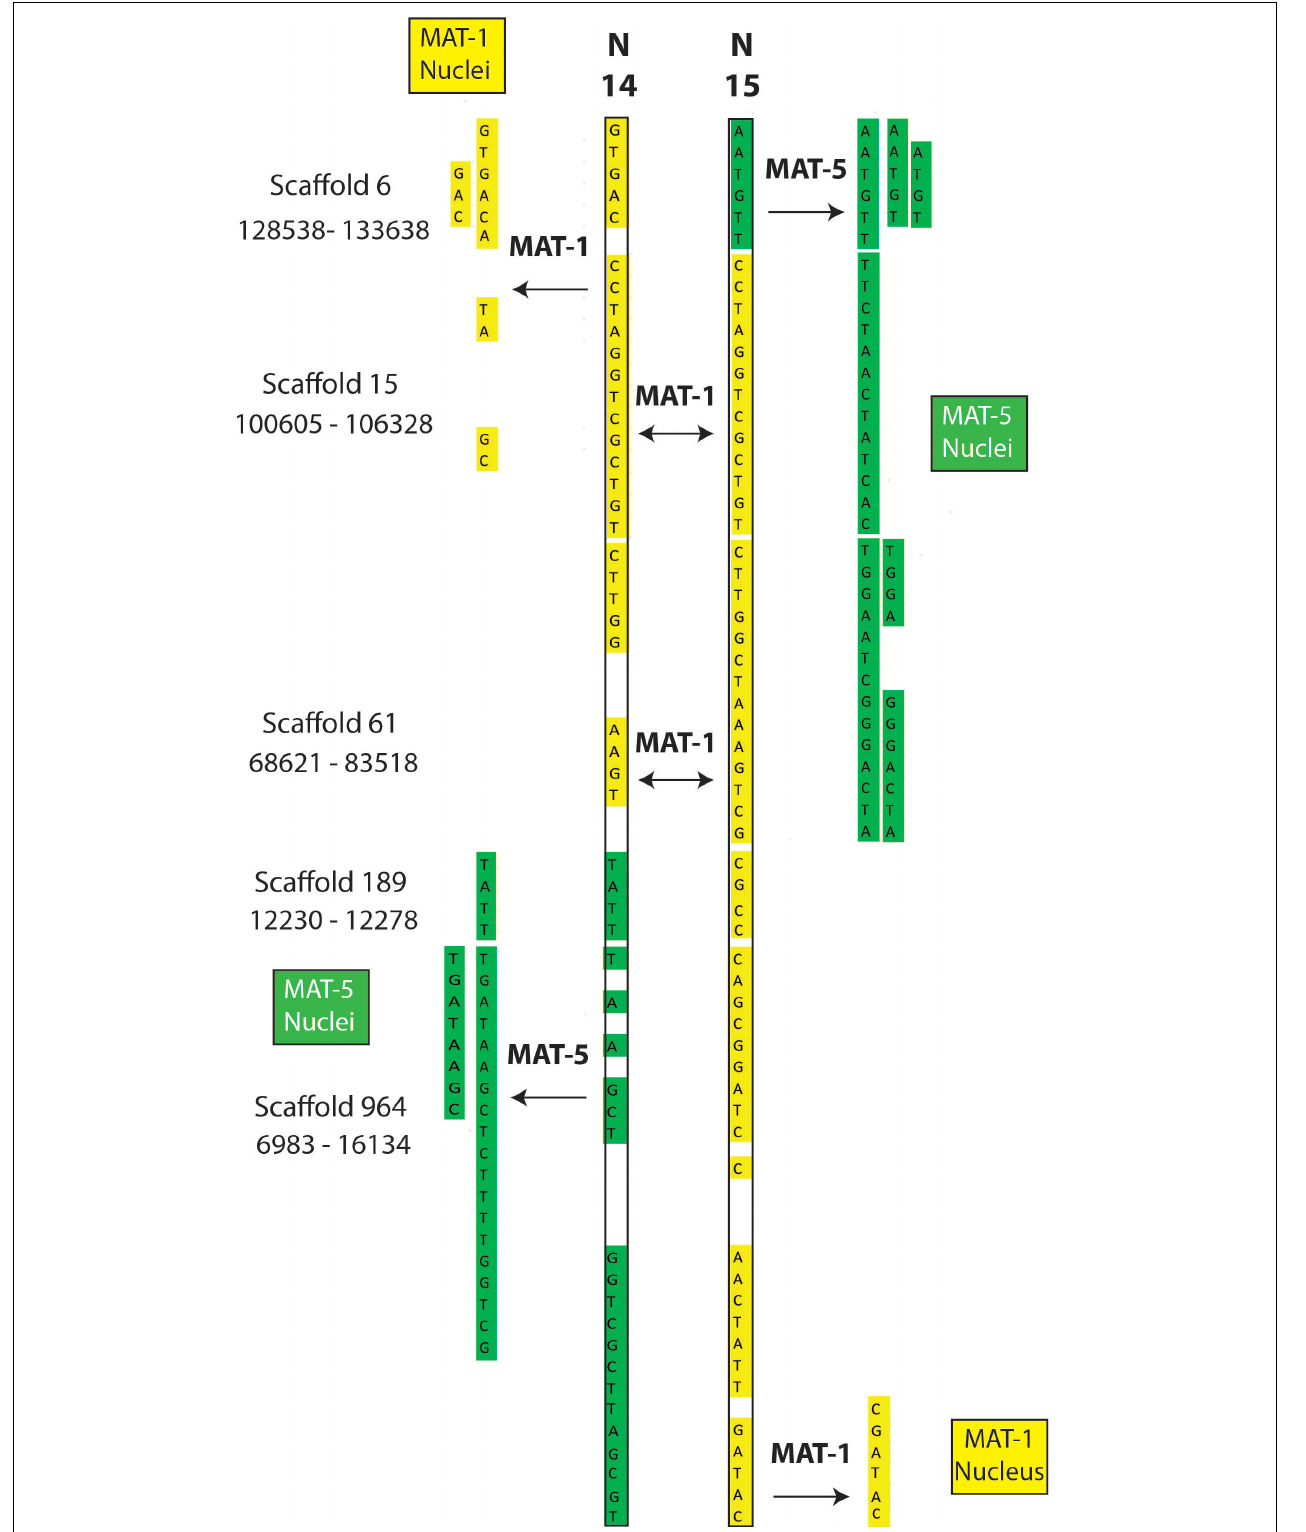
FIGURE 3 | Examples of recombination involving two nuclei (SN14 and SN15) of the dikaryotic isolate SL1. The regions are found along homozygous regions present only once in the reference genome of SL1. The nuclei N14 and 15 from SL1 carry the MAT-1 locus (validated by PCR) and, accordingly, their sequenced genotypes are almost identical. In some cases, however, each nucleus swaps genotype with the opposite MAT locus (i.e., genotype becomes green).